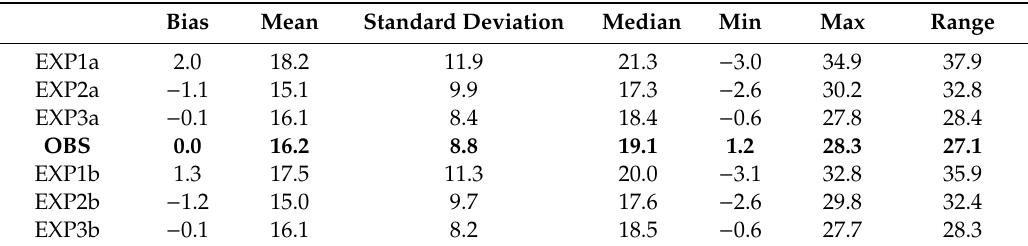
Table 10. TS ( ◦ C) (0–10 cm) simulated and observed at the FB station (data number 400). Bias Mean Standard Deviation Median